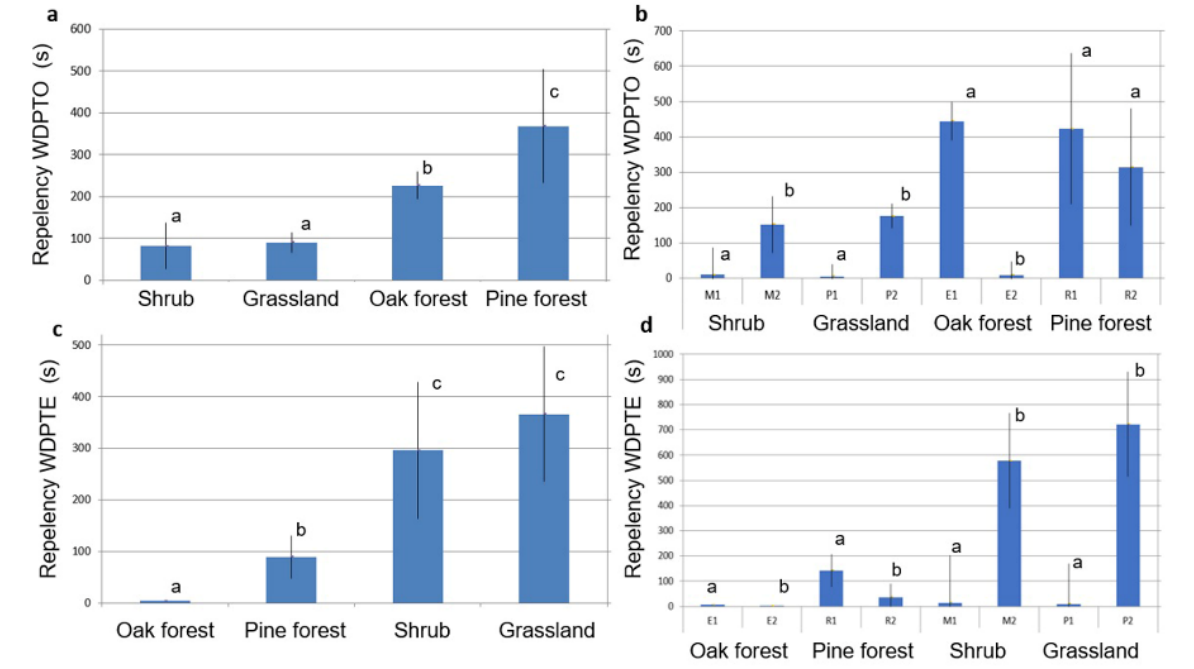
Figure 8. Mean plot of the soil repellency for the vegetation types ( left ) and for sampling plots ( right ). Error bars represent 95% confidence intervals. Different letters mean statistically significant differences, α = 0.05, between the vegetation types in ( a ) and ( c ), and between plots within each vegetation type in ( b ) and ( d ). Table 3. Factors influencing soil infiltration and soil repellency.